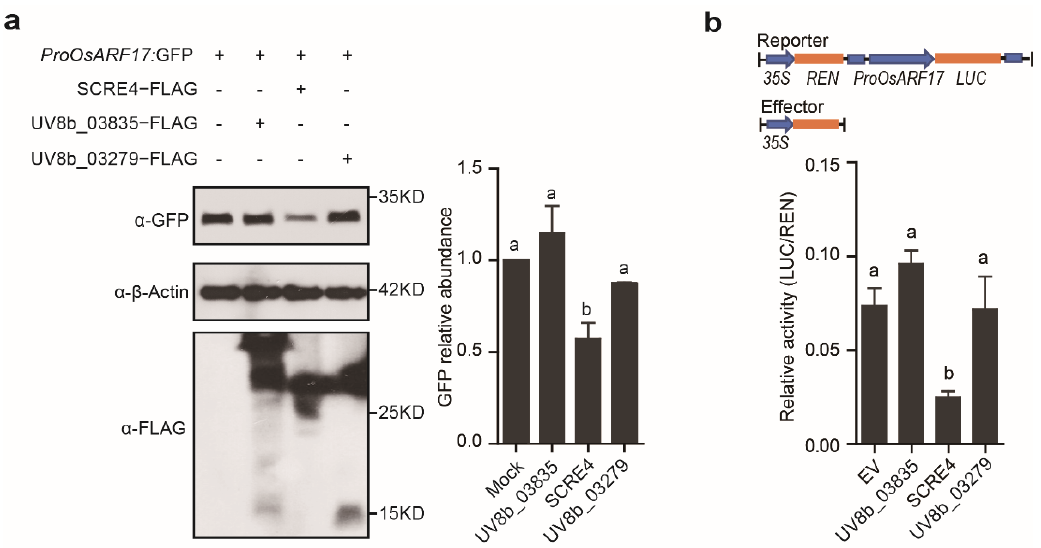
Figure 4. The transcriptional expression of OsARF17 is suppressed by the Ustilaginoidea virens effector SCRE4. ( a ) The GFP expression level driven by the OsARF17 promoter when it was individually co − expressed with SCRE4, UV8b_03835 and UV8b_03279 in rice protoplasts. The ProOsARF17:GFP construct was transfected alone or co − transfected with different putative effector gene constructs into rice protoplasts. The blots were detected via immunoblotting using anti − GFP, anti − β − Actin and anti − FLAG antibodies. The band intensity was quantified using ImageJ. Relative GFP abundance was normalized to the level of β − Actin. Right panel, data from three independent experiments are shown as mean ± SE. Different letters ( a vs. b ) indicate a significant difference in the GFP expression level ( p < 0.05, Duncan’s multiple range test). ( b ) The dual − LUC assay to show the relative LUC/REN activity when the ProOsARF17:LUC construct was co − transformed with different putative effector gene constructs in N. benthamiana . Upper diagram shows the features of the constructs used in the dual − LUC assay. The relative LUC/REN activity was measured after LUC, and putative effectors were transiently co − expressed in N. benthamiana leaves. Different letters ( a vs. b ) indicate a significant difference in the relative activity (LUC/REN) when LUC was co − expressed with different proteins ( p < 0.05, Duncan’s multiple range test).